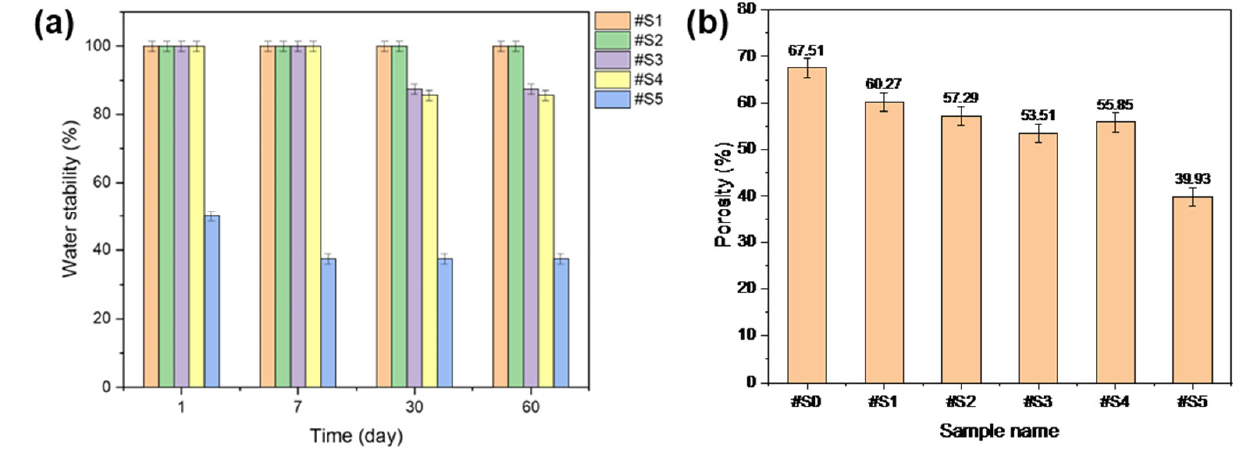
Figure 7. ( a ) Water stability and ( b ) porosity of the electrospun PLA and PLA/PEG-PPG-PEG nan- ofibers.